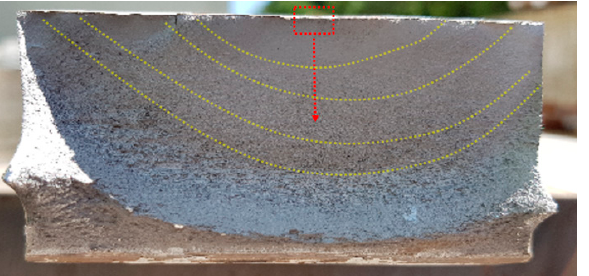
Figure 12. Determination of the fatigue crack initiation point (the point marked by the red box denotes the initiation point of the fatigue crack).